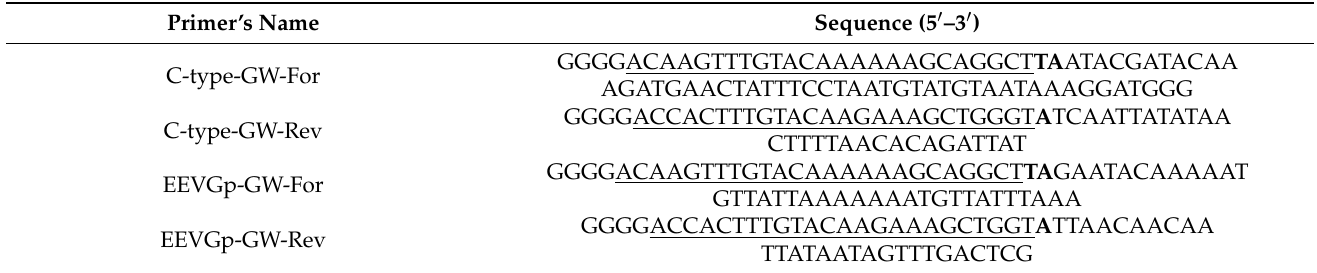
Table 1. Primer sequences containing attB sites used in the amplification and cloning of the target regions for Gateway